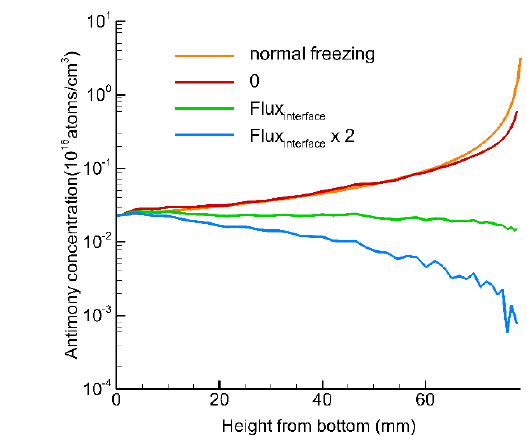
Figure 4. Distribution of phosphorus concentration in the crystal. The phosphorus evaporation flux at the melt surface was (i) 0 ( a ), (ii) the same as the phosphorus incorporation flux at the melt–crystal interface ( b ), and (iii) twice as large as that of case (ii) ( c ).